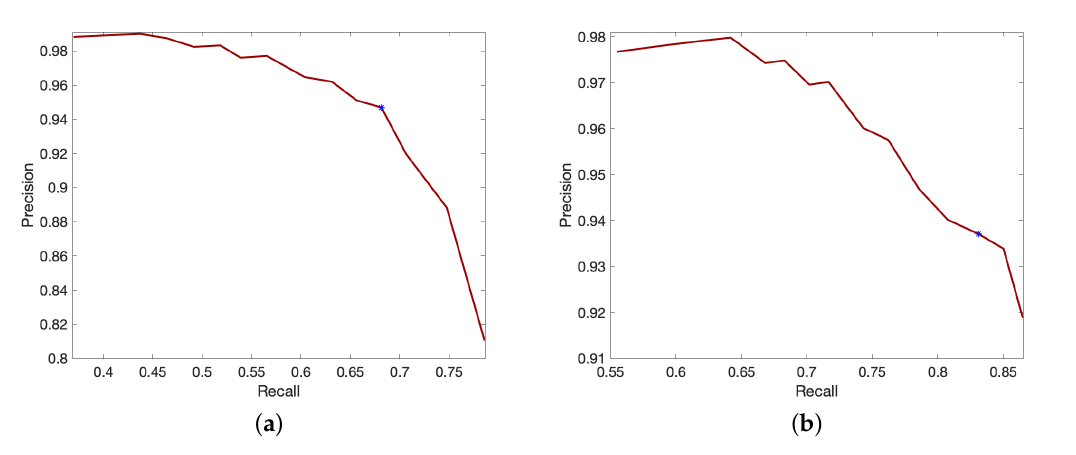
Figure 13. Recall and precision metrics for different thresholds. ( a ) Experiment 2, conf i . ( b ) Experiment 3, conf r